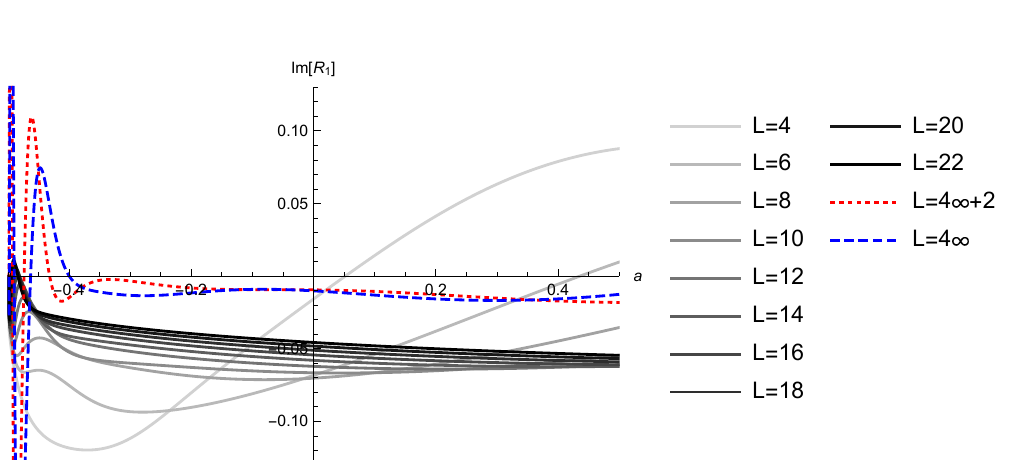
Figure 24 . Plots of the imaginary part of R 1 (A.3) of Φ G and dashed lines are extrapolations to L = 4 k + 2 ( k → ∞ ) and L = 4 k ( k → ∞ ), respectively. The horizontal axis denotes the value of the parameter a